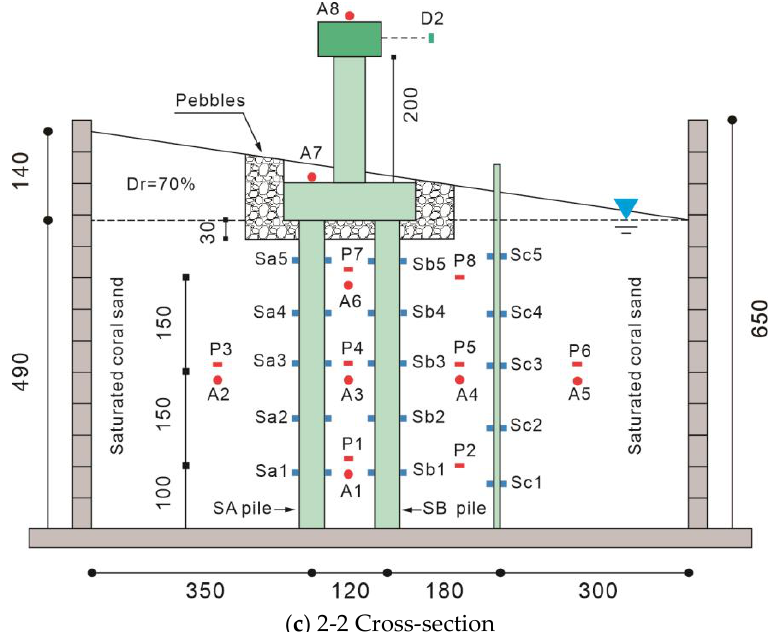
Figure 4. Component layout diagram (unit: mm).